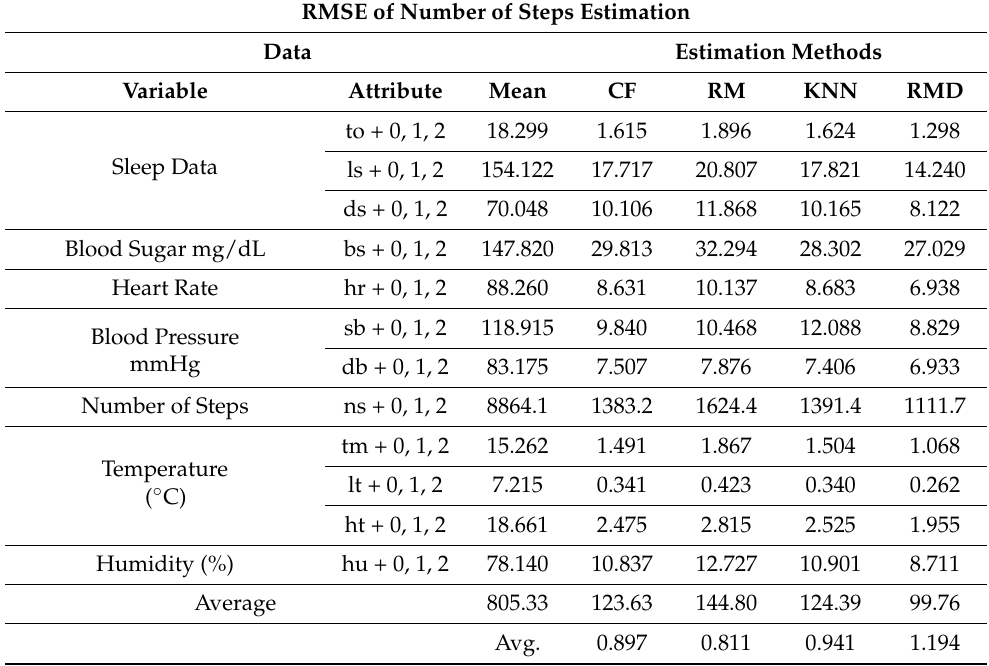
Table 6. RMSE and turnaround time of each missing value estimation methods. RMSE of Number of Steps Estimation